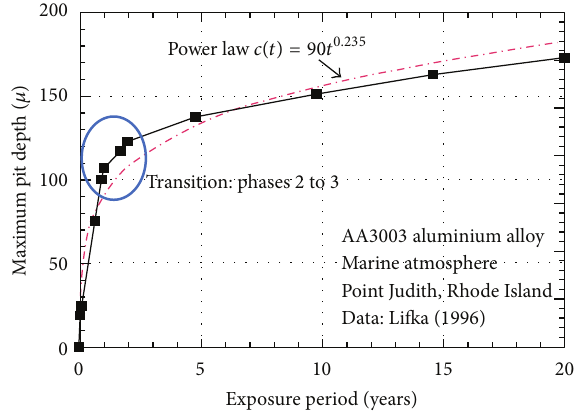
Figure 7: Data for maximum pit depth of aluminium alloy AA3003 exposed in the marine atmosphere at Rhode Island, NJ, for up to 20 years. The trend for maximum pit depth is shown. The location where the changeover from mode 2 to mode 3 is expected to occur is shown circled, at about 2 years of exposure. Data from Lifka [29].